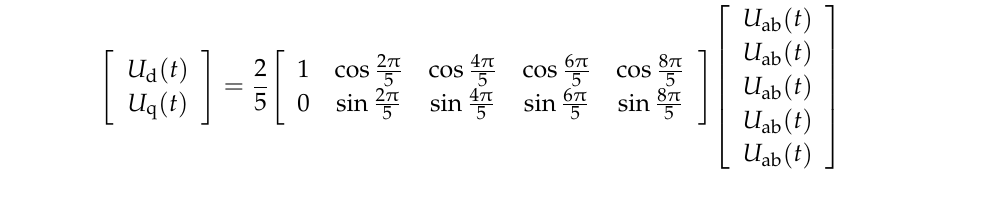
Table 2. Vectors of output side.